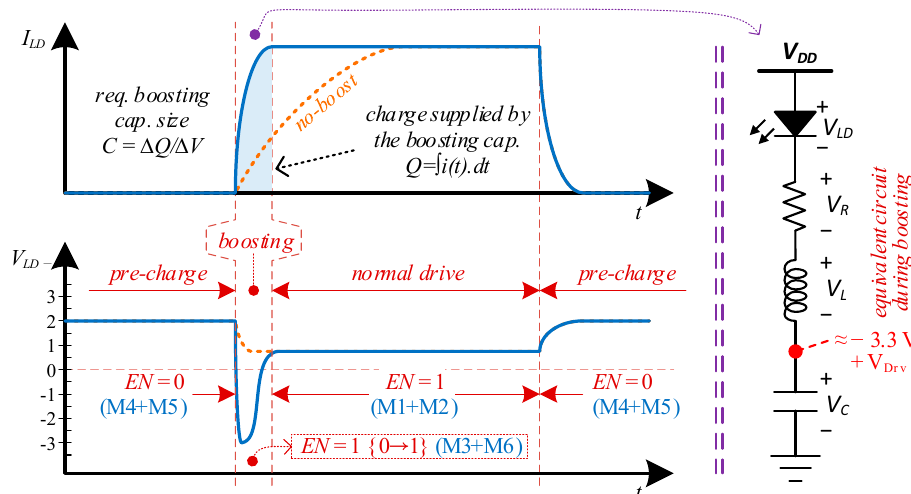
Figure 5. Operational phases and equivalent circuit during the boosting phase (for calculating the amount of charge supplied).